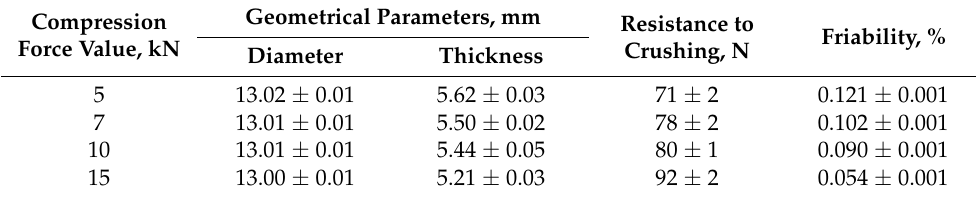
Table 2. Geometrical parameters and mechanical resistance characteristics of MCGs. Compression Force Value,